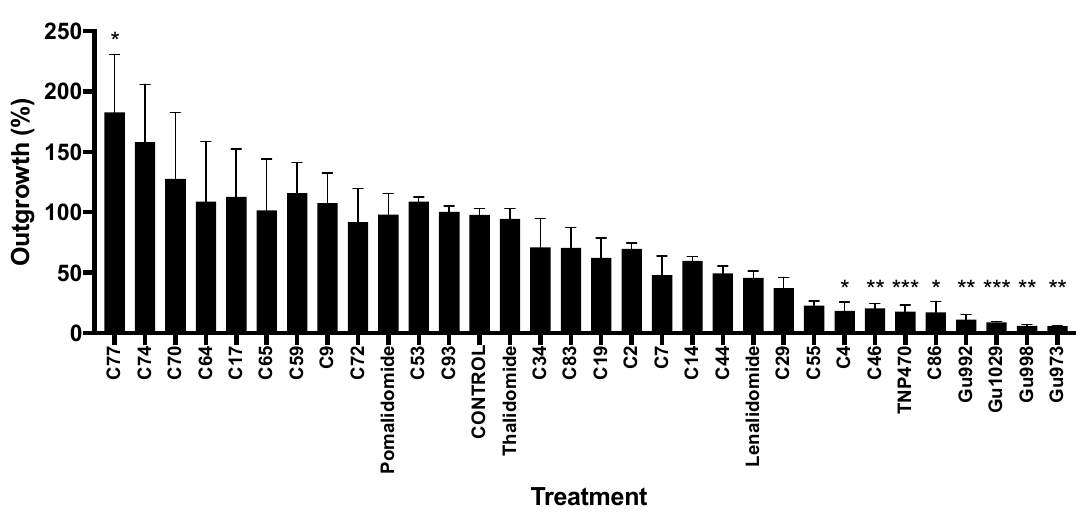
Figure 2. Graphical representation of rat aorta ring (RAR) assay outgrowth. A minimum of three rings were used per treatment. Error bars are SEM. Statistical analysis was performed in Prism and is multiple comparisons (Dunnett’s test) one-way ANOVA (* p < 0.05; ** p < 0.01; *** p < 0.001).